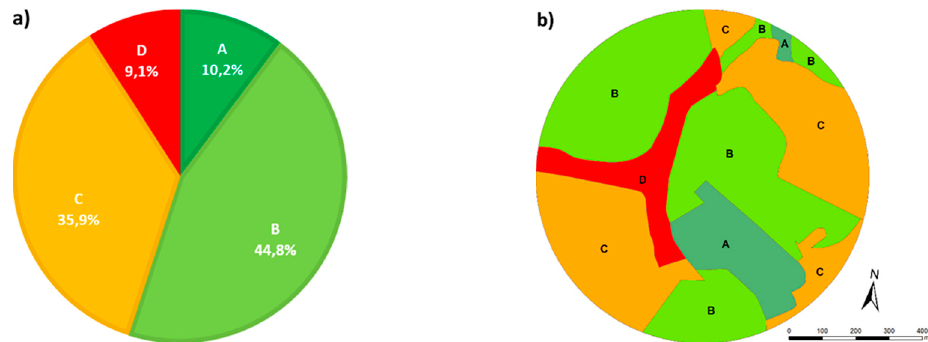
Figure 6. Land cover development at Site B.